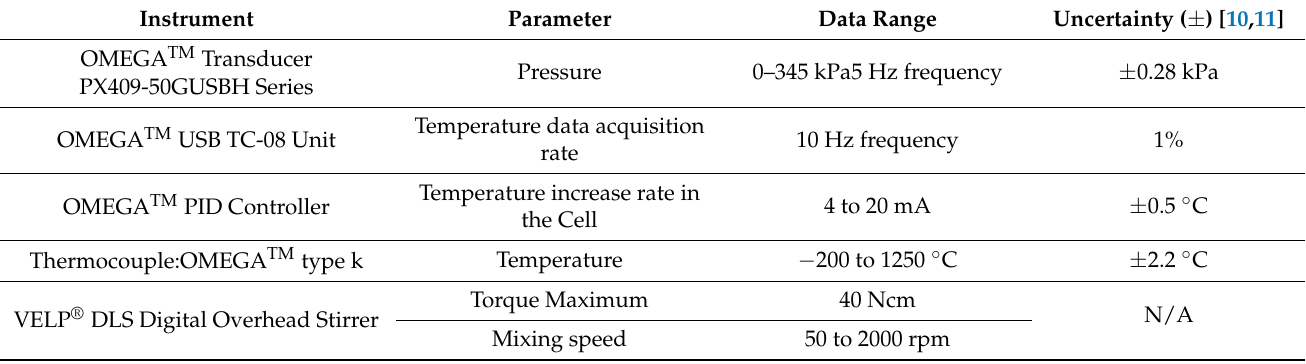
Table A2. CREC-VL-Cell Data-based Process Instruments.